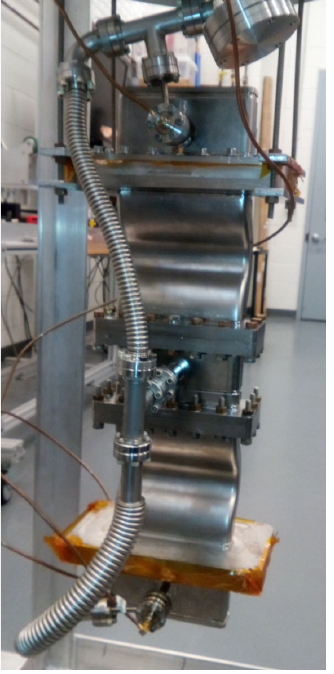
FIG. 6. Double dogleg and window waveguide resonator for characterizing rf losses of cold windows at LHe temperature in a vertical cryostat at low power value using a vector network analyzer. The top dogleg contains a reference cold window that is always employed as a reference, with known losses, against which a second cold window in a second dogleg is measured.